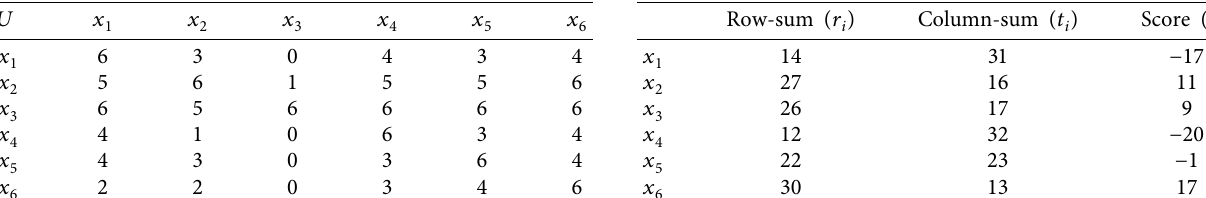
Table 6: o ( H ,E ) . i scores of Λ s